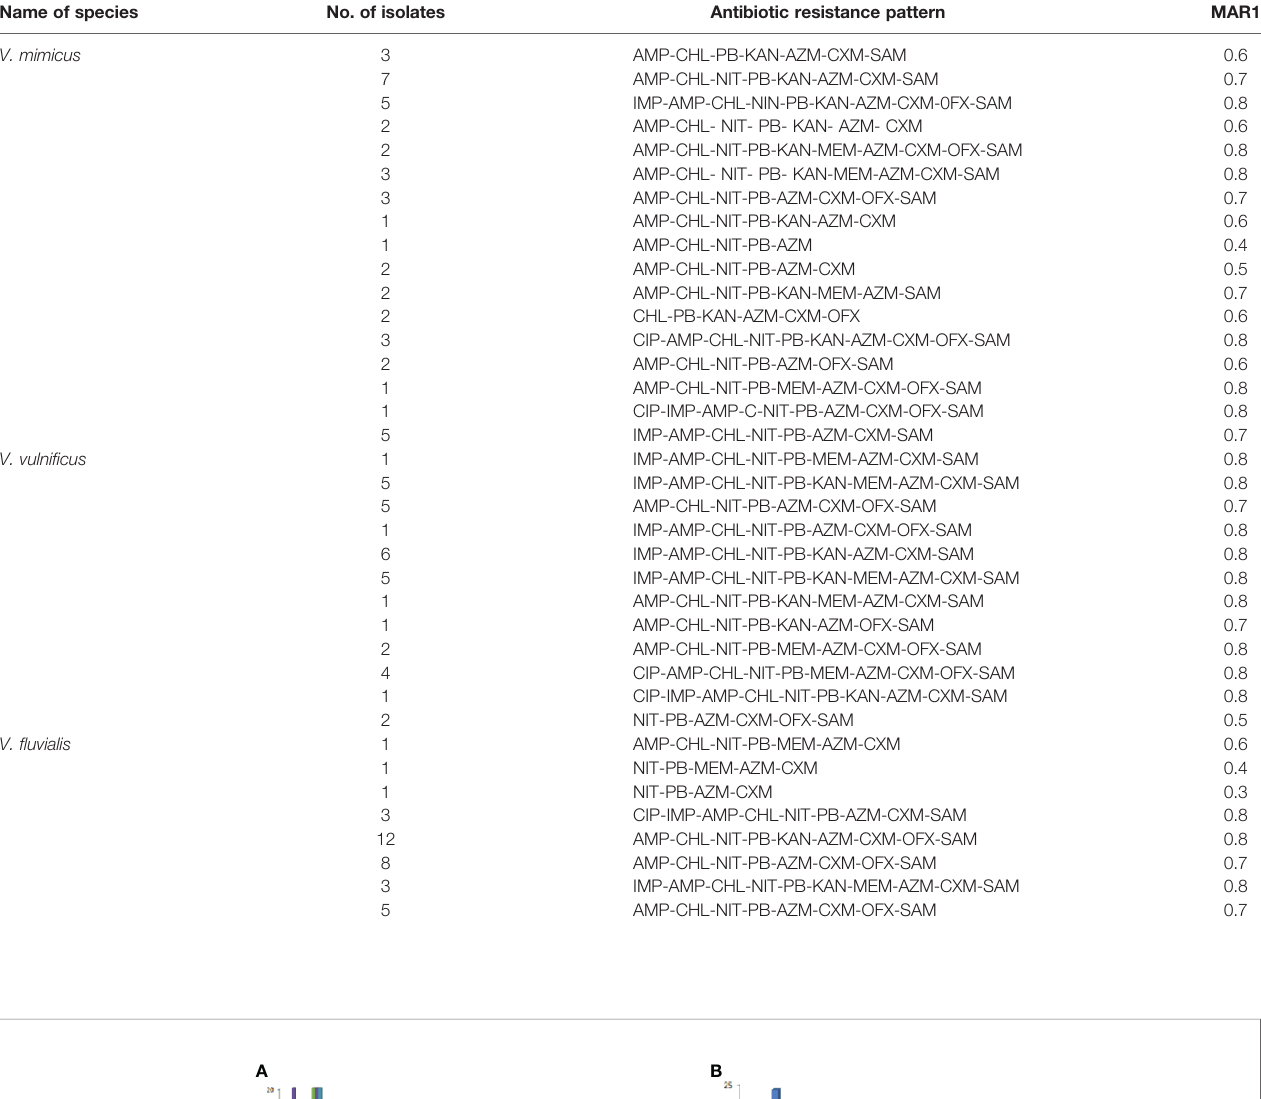
TABLE 4 | Multiple antibiotic resistance pattern and MARI of Vibrio isolates. Name of species